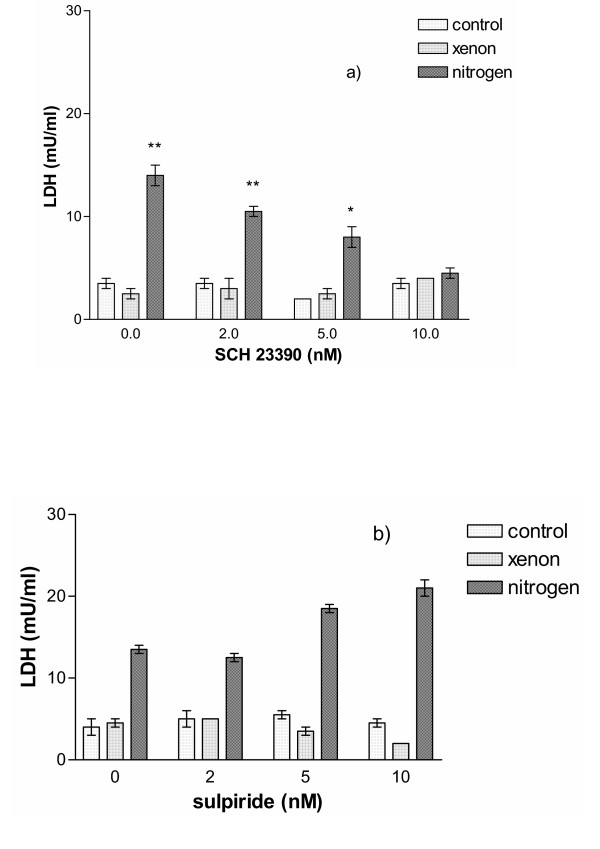
A. Effect of various concentrations of the D1-receptor antagonist SCH 23390 on cell survival after two-hour incubation. No effect was observed on PC-12 cells maintained under normal conditions or in xenon, however, for cells kept in nitrogen, a concentration-dependent decrease of cellular damage was found, indicating that the D1-receptor was involved to convey the cellular damage. (n = 4; **P < 0.01 and *P < 0.05 with respect to untreated controls). B. Effect of various concentrations of the D2-receptor antagonist sulpiride on cell survival after two-hour incubation. No protective effect of sulpiride was found for cells incubated in nitrogen, even a slight increase of cellular damage was seen with increasing concentrations of sulpiride.